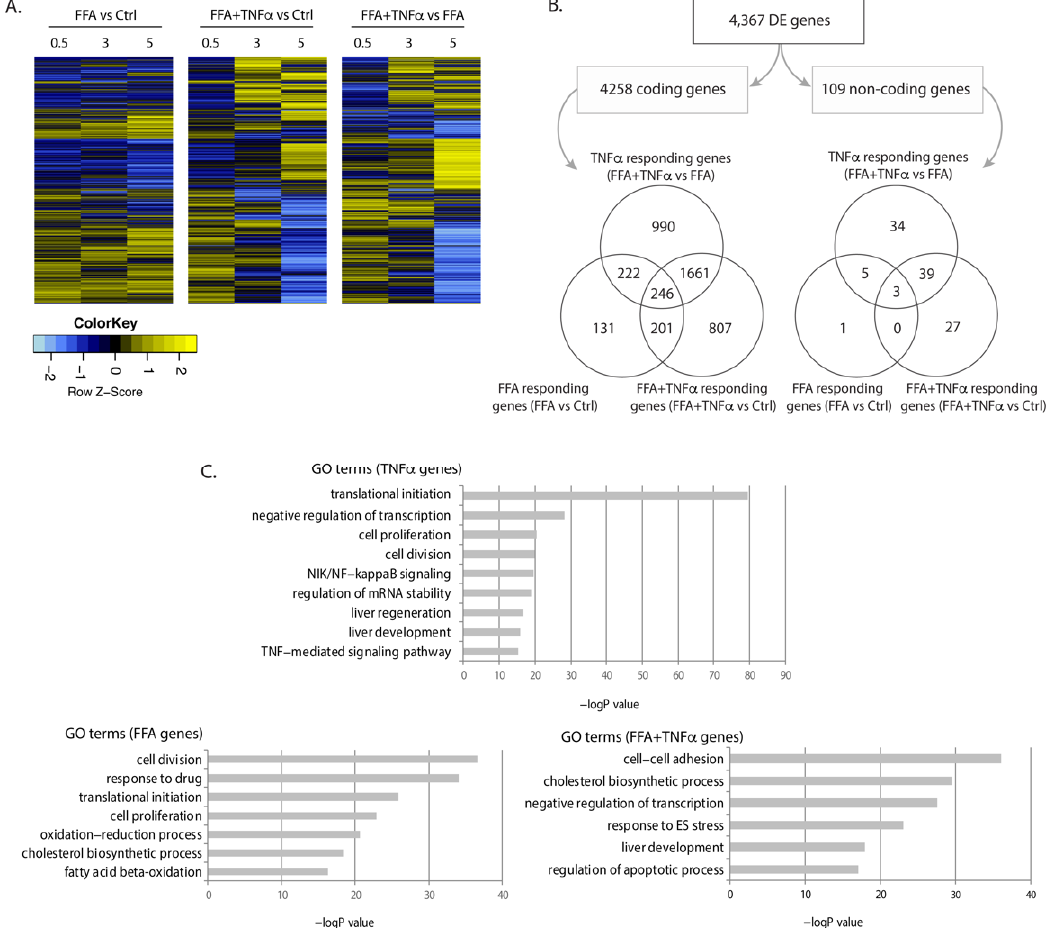
Figure 2. Differentially expressed genes upon FFA and TNF α stimulation. ( A ) Heatmap of differentially expressed (DE) genes in each condition at FDR < 0.1. Fold change of gene expression Z-scores is shown. ( B ) Number and Venn diagrams of DE genes at FDR < 0.1 in each condition for coding (left) and non-coding genes (right). ( C ) Pathway analysis for DE coding genes including gene ontology (GO) terms and false discovery rate (FDR) for each condition.